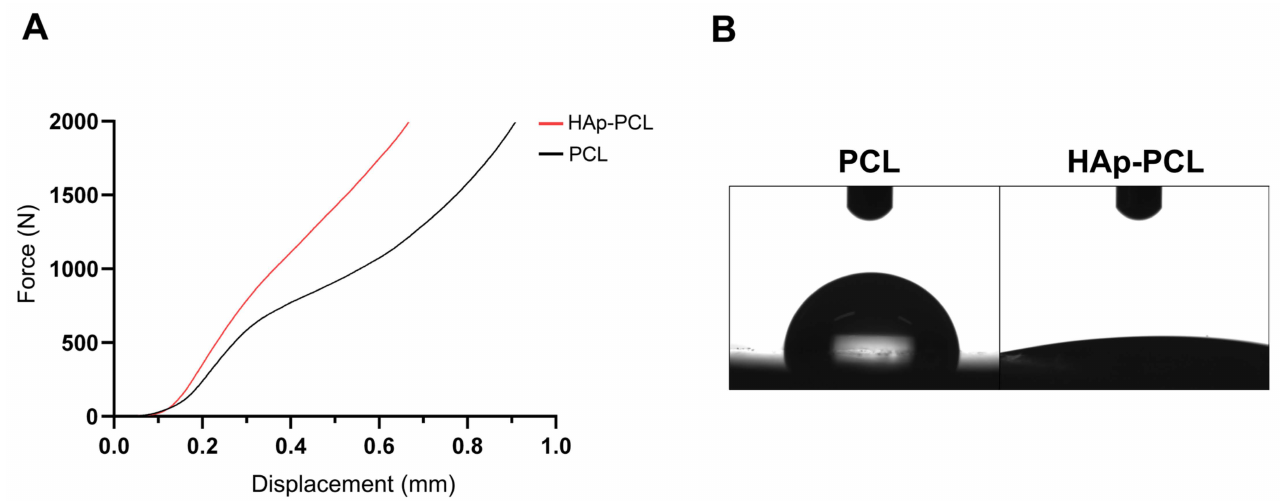
Figure 2. Mechanical and physicochemical surface properties of PCL-based discs/scaffolds. ( A ) Com- pressive strain curves of PCL and HAp-PCL scaffolds. ( B ) Images of water droplet on the surface of PCL and HAp-PCL